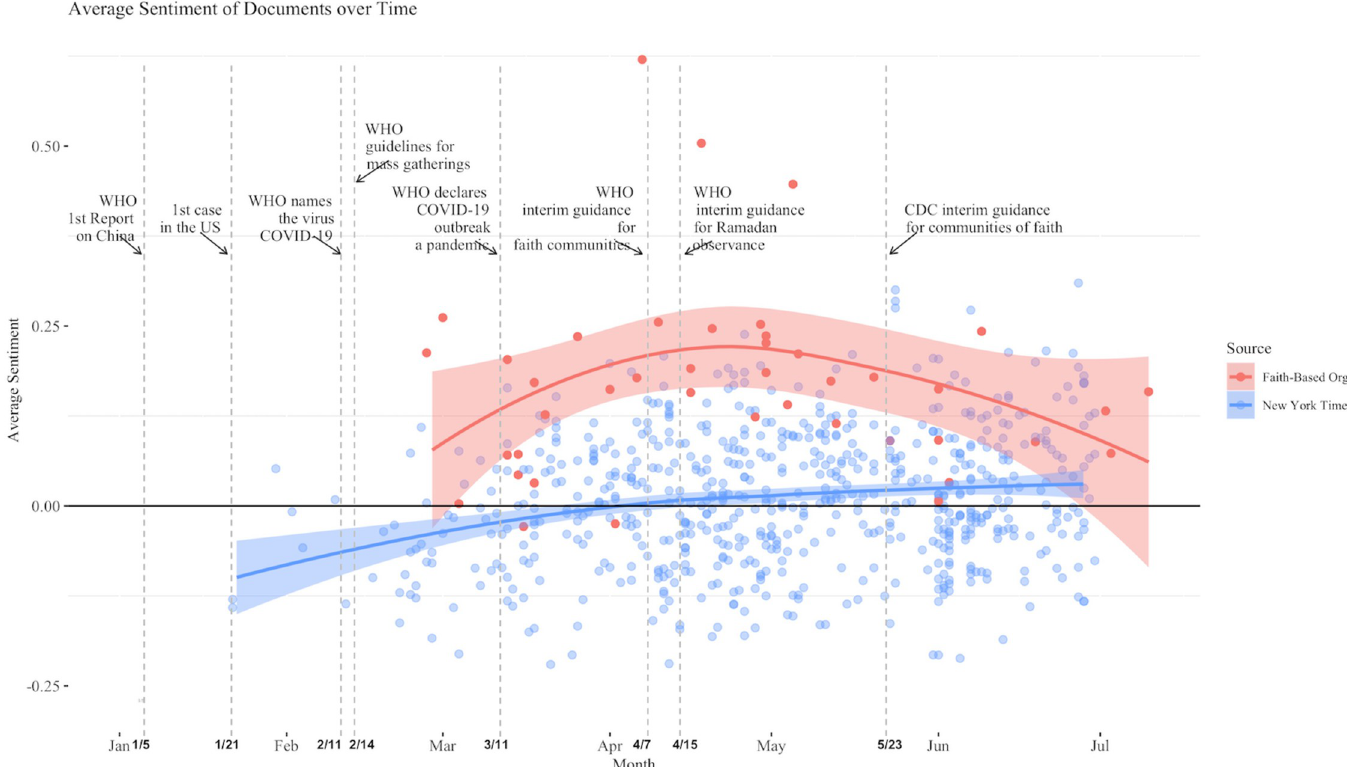
Fig 1. Average sentiment scores for New York Times articles and COVID-19 guidance documents from faith-based organizations and loess curves indicating sentiment trends over time.